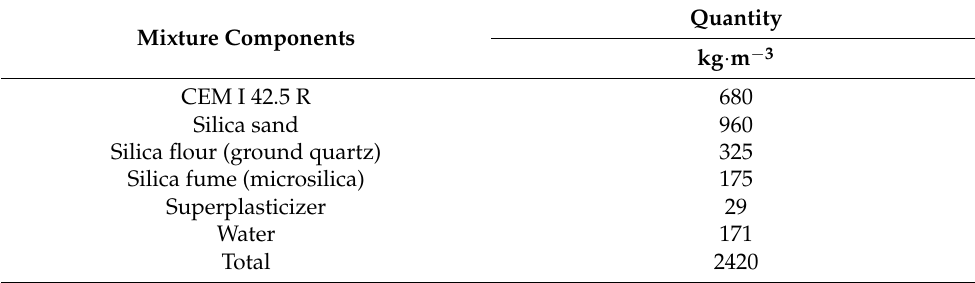
Table 1. HPC component mixture of [4].